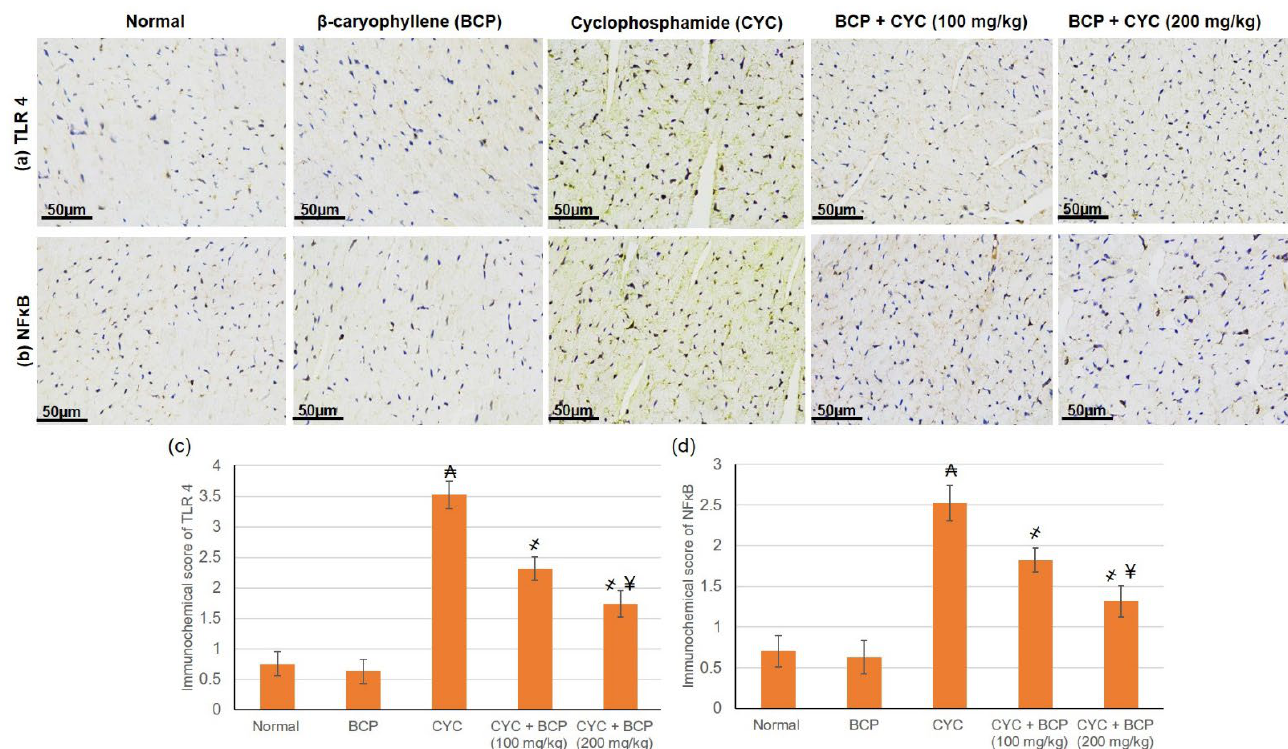
Figure 4. Effects of treatment with β -caryophyllene (BCP) for 14 days on cyclophosphamide (CYC) induced expression of ( a ) toll-like receptors 4 (TLR 4) and ( b ) NFκB by immunohistochemical staining in cardiac tissues, ( c , d ) showing semiquantitative analysis of TLR 4 and NFκB immunohistochemical staining. All values are expressed as mean ± SD. ₳ indicates a statistically significant difference from normal group; indicates a statistically significant difference from CYC group; ¥ indicates a statistically significant difference from CYC + BCP (100 mg/kg) utilizing one-way ANOVA ҂